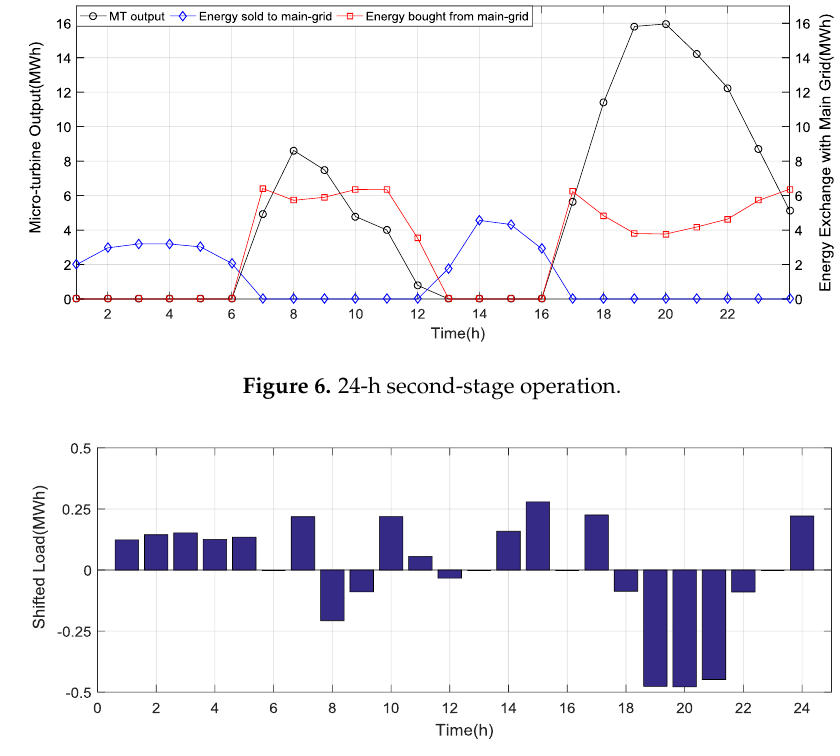
Figure 8. Voltage profile of critical nodes in different cases. 5.5. Statistical Feasibility Check To verify the robustness in addressing various scenarios, the proposed model was tested with 1079 scenarios, randomly generated from a three-year dataset of wind power, PV, and load demand